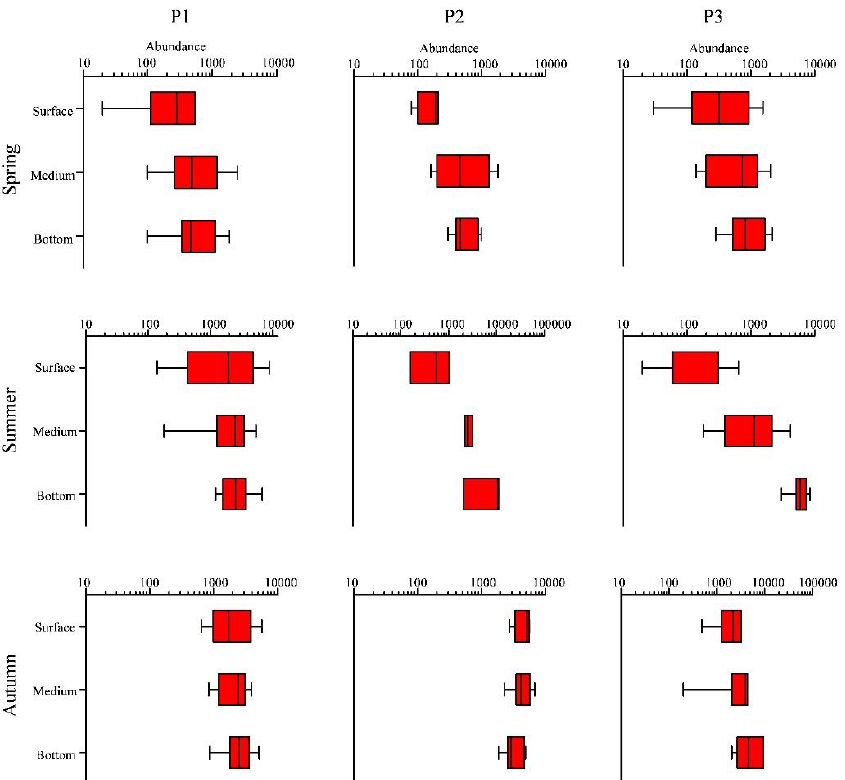
Figure 8. Box-Whisker plots of phytoplankton cell abundance (cells · L − 1 ) in the BS and NYS in the three seasons. Whiskers mean minimum and maximum values; boxes display the lower and upper quartiles; and lines mean median sets. P1, P2 and P3 are the provinces grouped.